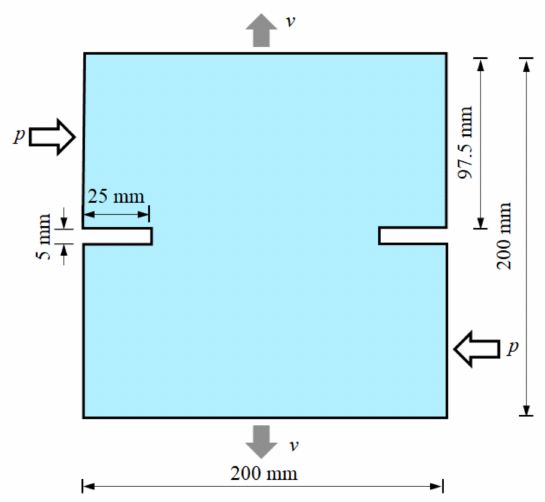
Figure 18. Geometric dimensions of a double-edged notched